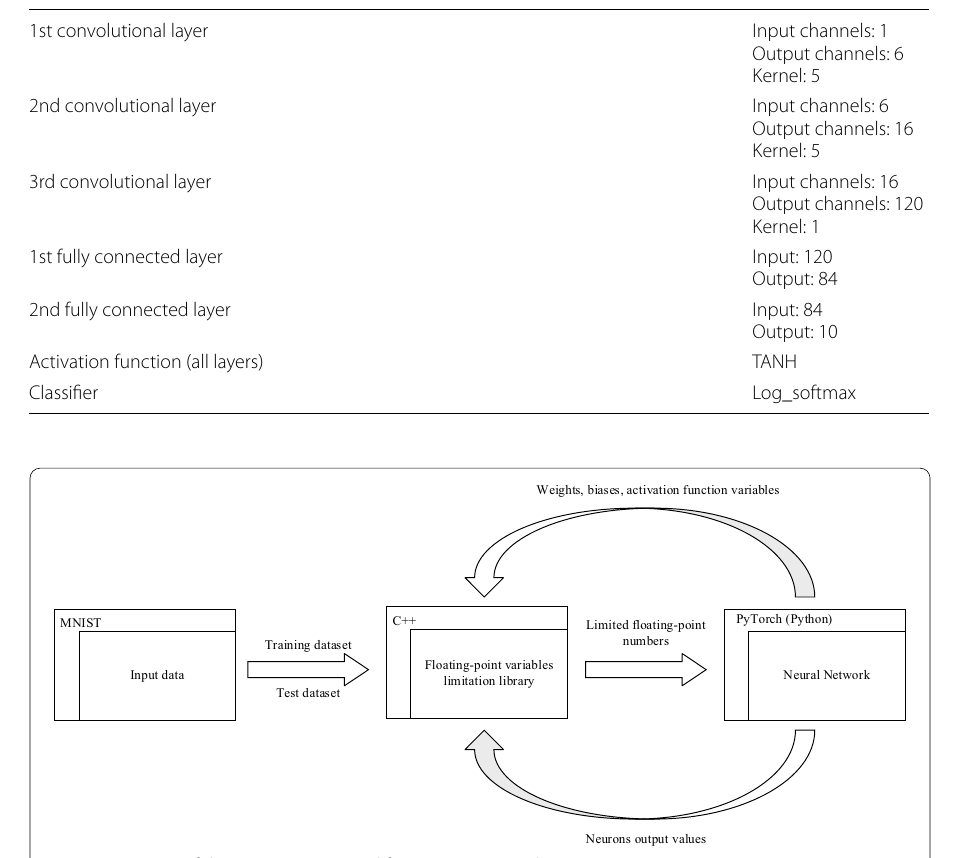
Table 2 LeNet-5 structure used for experiments Item